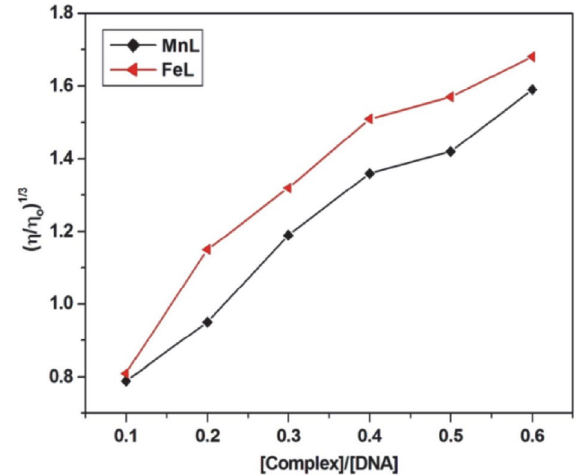
Fig. 3: Effect of increasing amounts of MnL and FeL on the relative viscosities of CT-DNA at room temperature in 5 mM Tris-HCl